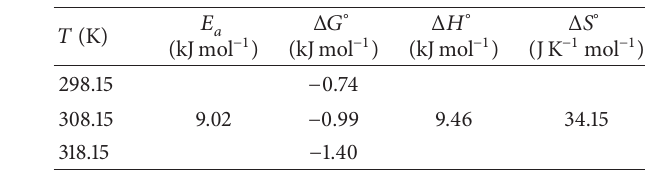
Table 2: Thermodynamic parameters calculated from the Langmuir isotherm constant, 𝐾 𝐿 , and activation energy calculated from the , for the adsorption of lead pseudo-second-order rate equation, k 2 (II) ions onto the activated carbon (SAC2).